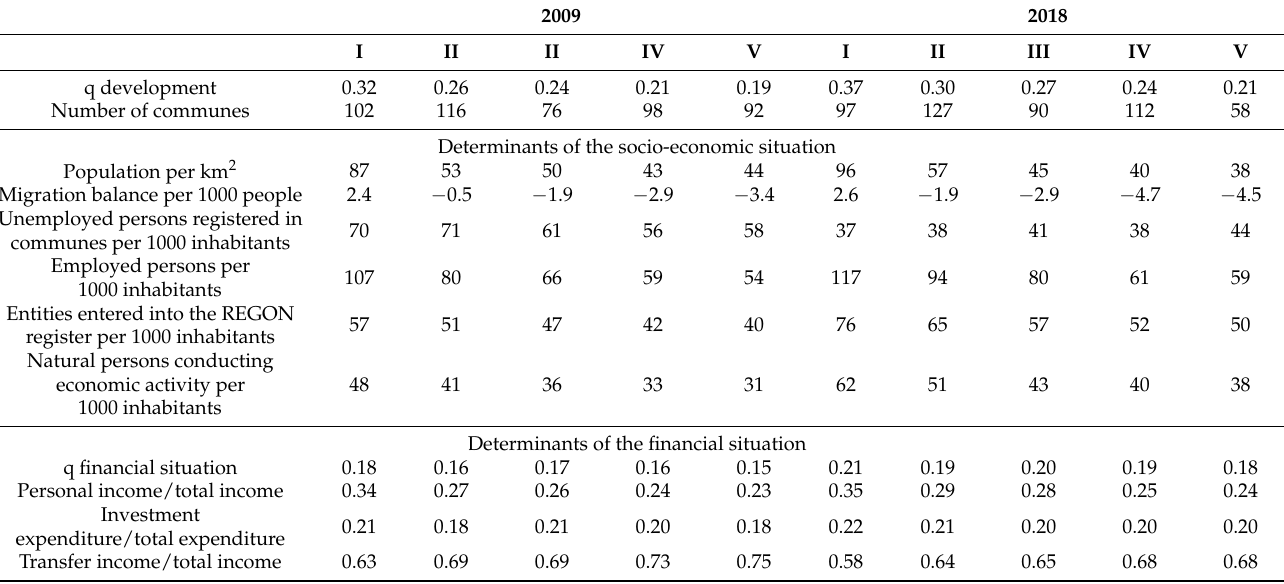
Table 3. Values of indicators describing the socio-economic and financial situation of rural communes in eastern Poland in 2009 and